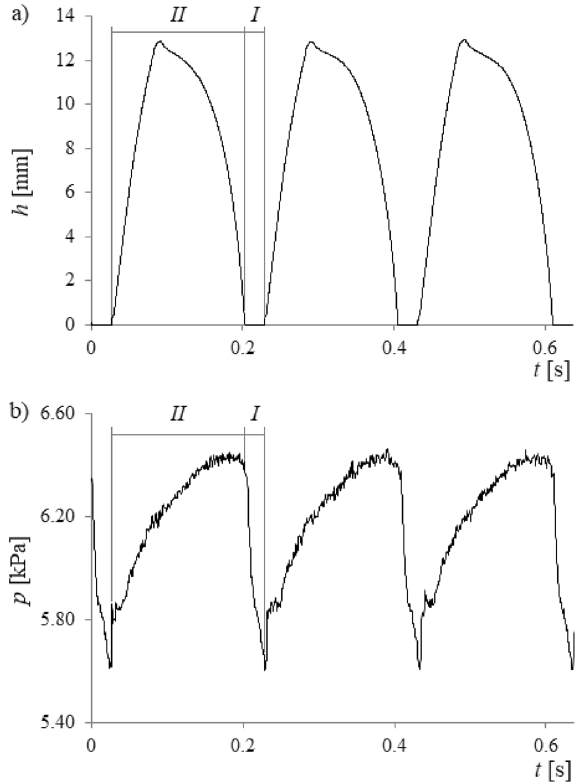
Figure 3. Example of recorded time series. ( a ) Liquid movement inside the glass capillary, ( b ) resulting pressure changes in the gas supply